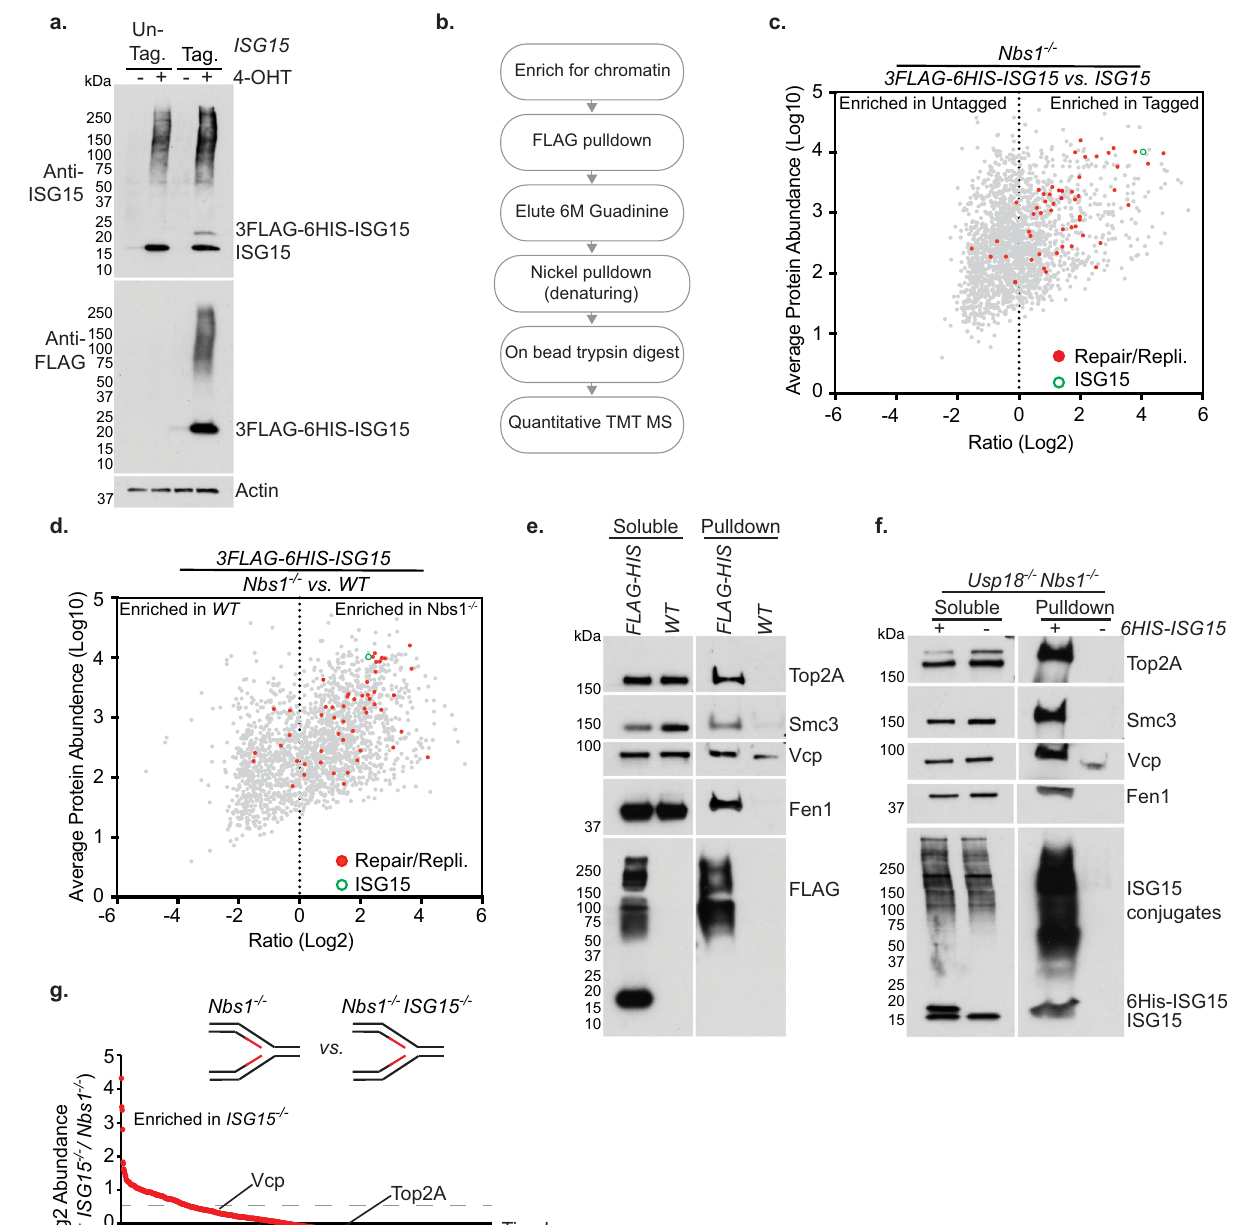
Fig. 4 | Protein ISGylation occurs at replication forks.a Western blot analysisof whole cell extracts taken from Nbs1 f/f and Nbs1 f/f 3FLAG-6HIS-ISG15 with or without 4-OHTinduced Nbs1 deletion. b Diagrammaticrepresentationoftheapproachused to identify ISGylated proteins in c and d . c Mass-spectrometry hits from Nbs1 − / − vs. Nbs1 − / − 3FLAG-6HIS-ISG15 MEFs. Mean Log2 ratio and Log10 abundance of two independentexperimentsshown. d Mass-spectrometryhitsfrom 3FLAG-6His-ISG15 vs. Nbs1 − / − 3FLAg-6HIS-ISG15 MEFs . Mean Log2 ratio and Log10 abundance of two independentexperimentsshown. e Westernblotanalysisofnickelpulldownsfrom thechromatinfractionof Nbs1 − / − and Nbs1 − / − 3FLAG-6HIS-ISG15 MEFs.Solubleinputs